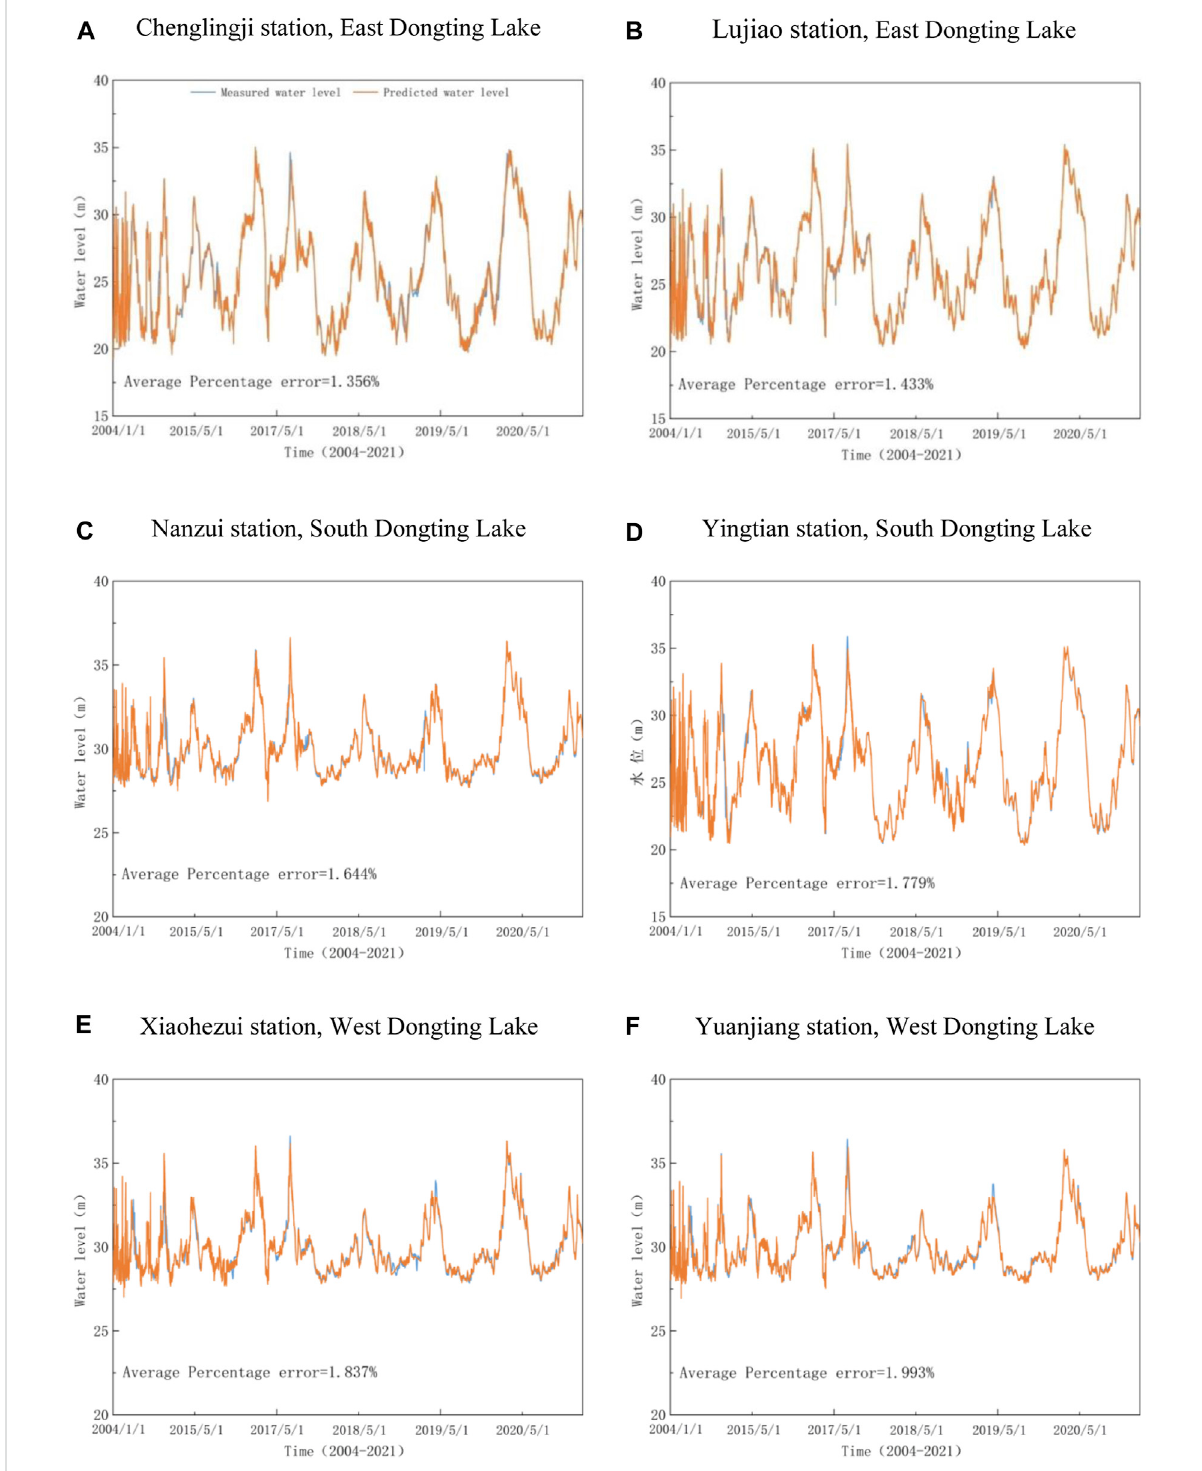
FIGURE 6 Plot for observed water level and predicted water level using PSO-ENN model. (A) Chenglingji station, East Dongting Lake. (B) Lujiao station, EastDongtingLake. (C) Nanzuistation,SouthDongtingLake. (D) Yingtianstation,SouthDongtingLake. (E) Xiaohezuistation,WestDongtingLake. (F) Yuanjiang station, West Dongting